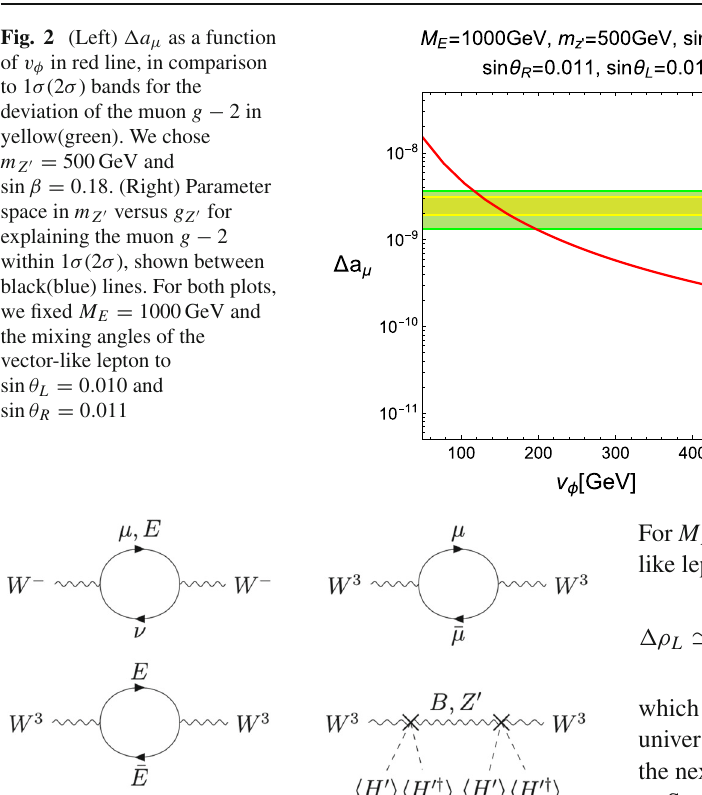
Fig. 3 Feynman diagrams for the self-energy corrections for elec- troweak gauge